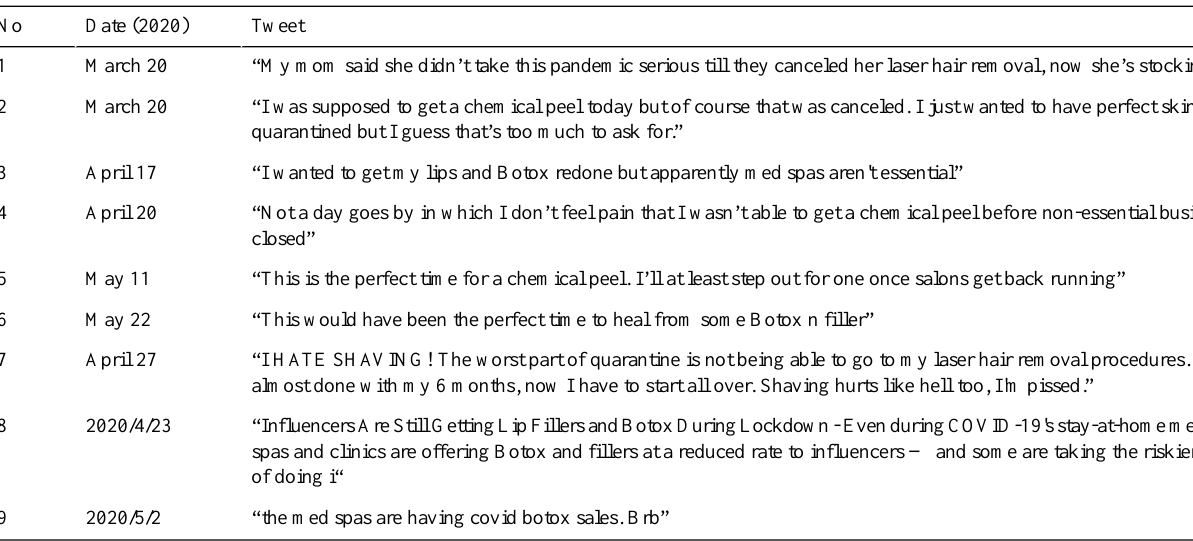
Table 1. Typical tweets related to plastic procedures. Only the tweets and their publication dates are provided to protect the privacy of their writers. The tweet contents were minimally revised to remove some foul